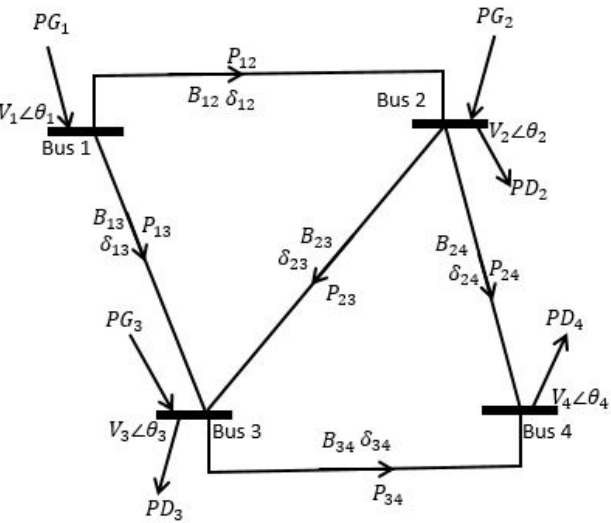
Figure A1. The line diagram of a 4-Bus test